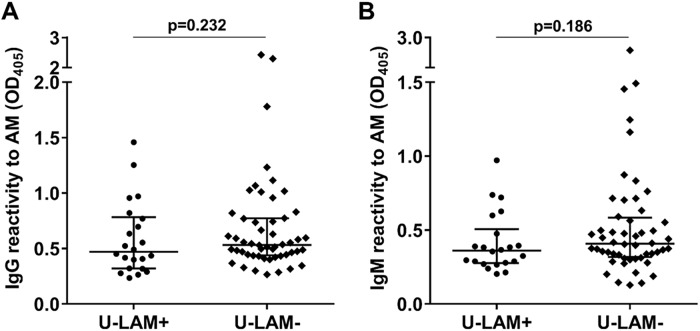
Comparison of IgG response to AM between U-LAM+ and U-LAM- TB+ subjects.(A) IgG to AM; (B) IgM to AM. Lines and error bars represent medians with interquartile ranges. Mann-Whitney U test was used for statistical comparisons.